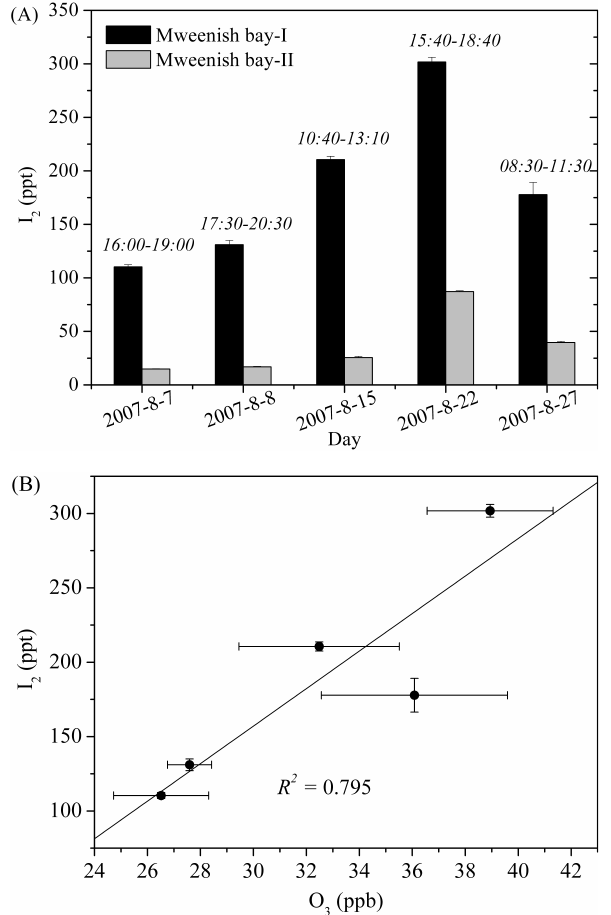
Fig. 2. Comparison of the mixing ratio of I 2 between Mweenish Bay-I and Mweenish Bay-II (A) , and the correlation between the emission of I 2 and O 3 in the surrounding air at Mweenish Bay-I (B) , measured directly above the algal